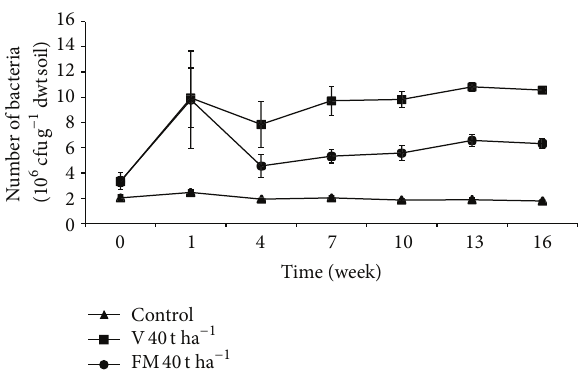
Figure 4: Changes in number of total aerobic mesophilic bacteria in soils treated with vermicompost (V) and farmyard manure (FM) at the rate of 40 tha −1 . Error bars represent standard errors based on four